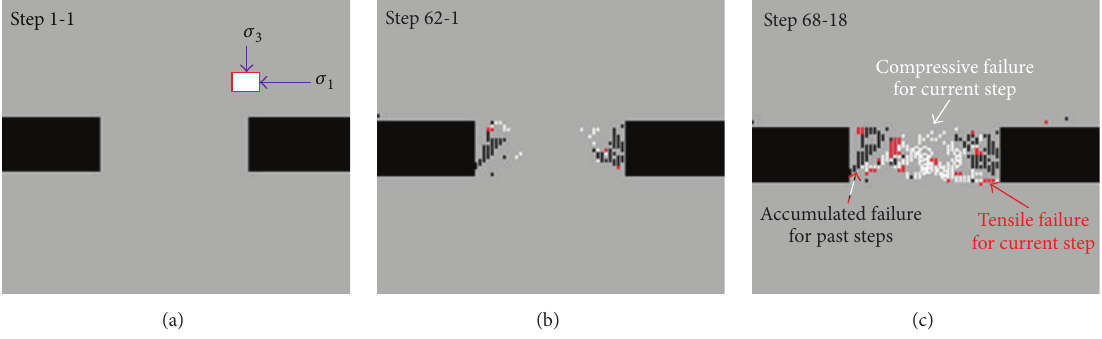
Figure 17: Plot of acoustic emissions for a pillar with width-to-height ratio = 2.5.